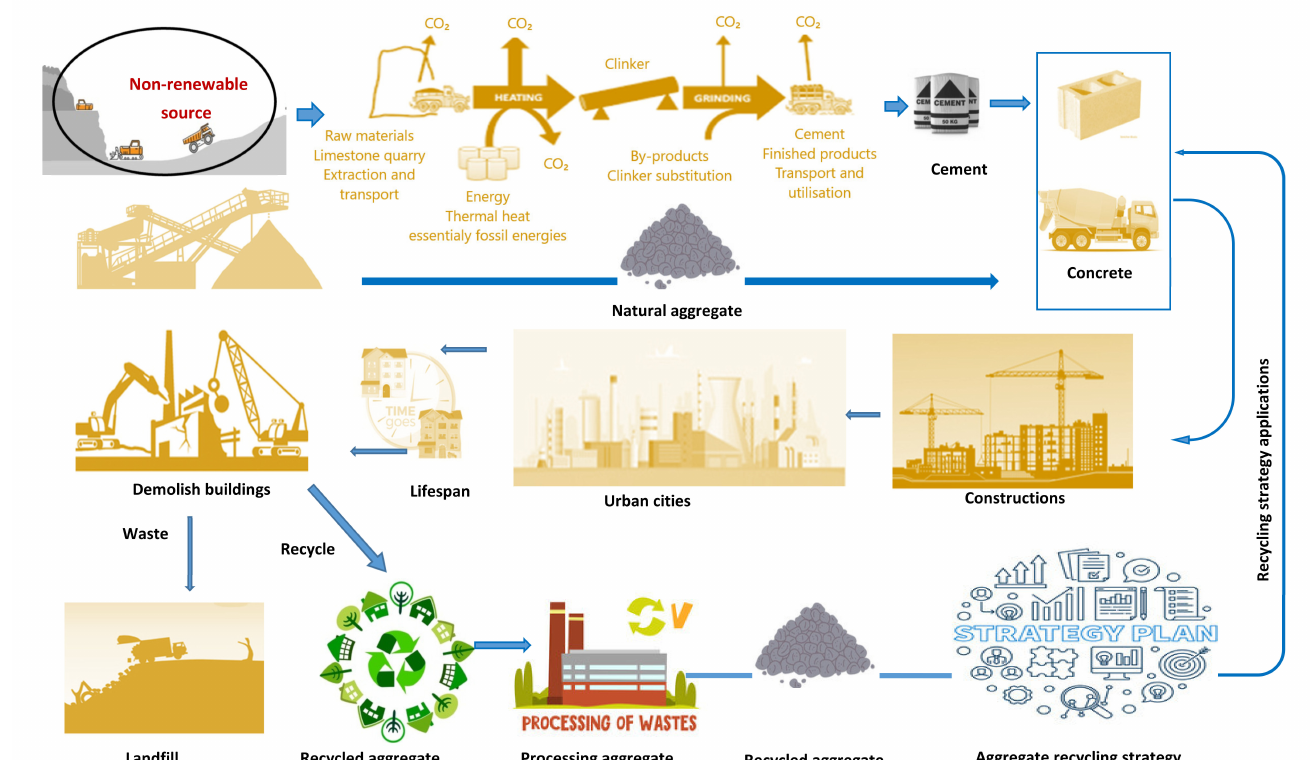
Figure 3. Principles of designing a strategy for